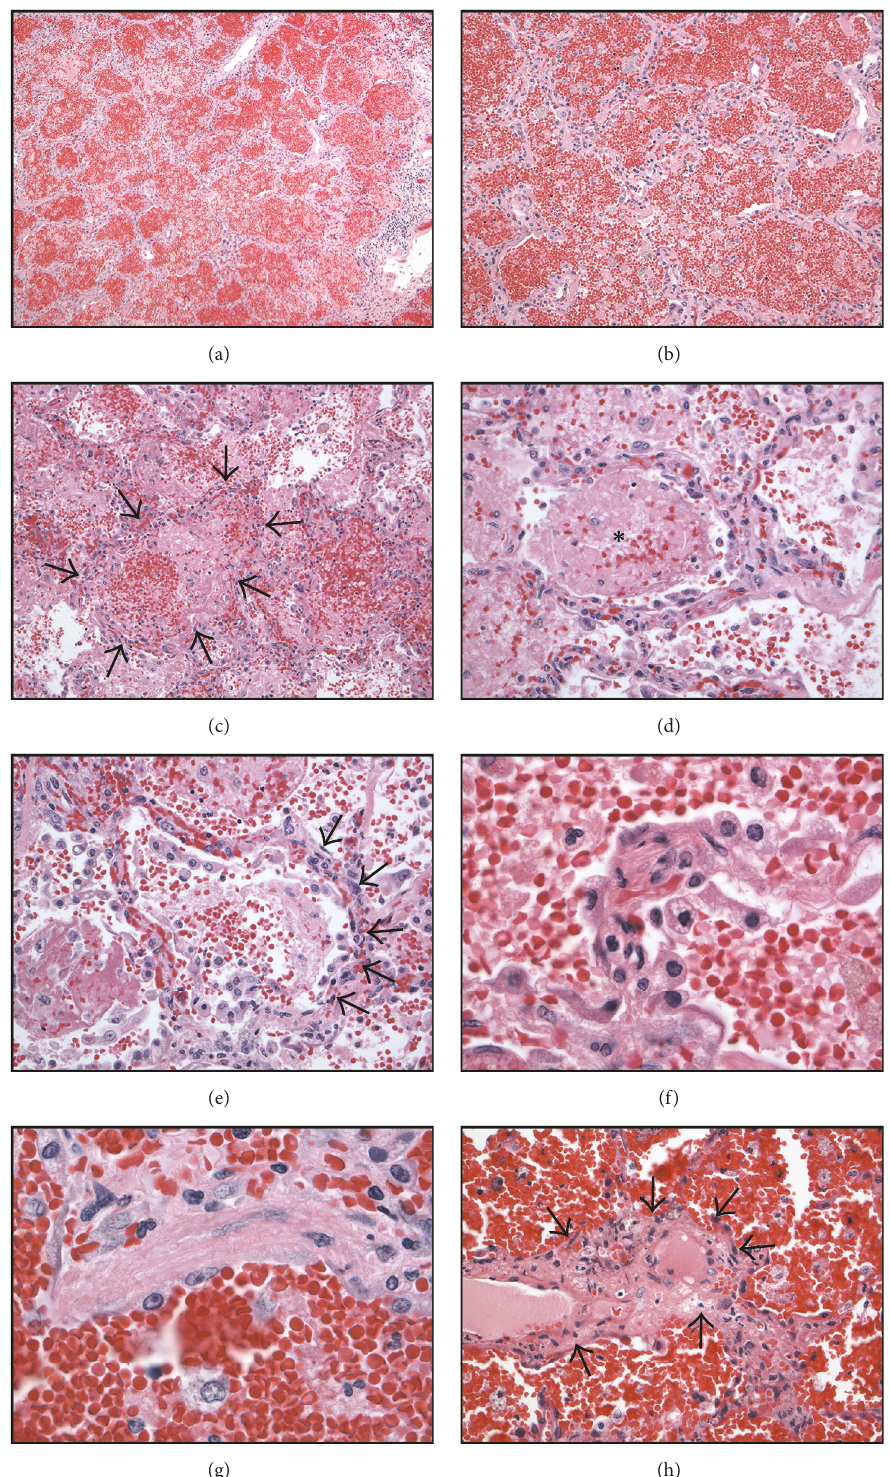
Figure 4: Lung with diffuse alveolar hemorrhage (H&E stain). (a) Area in which all alveoli are filled with extravasated erythrocytes. (b) Higher power view of same region. Note the hypercellularity of the alveolar septa. (c) A mixture of red cells and fibrin predominates in some alveoli (arrows). (d) The central alveolus contains a fibrin plug (asterisk). The alveolar septum is hypercellular. (e) The alveolar septum shows capillaritis (arrows), an inflammatory infiltrate containing neutrophils that degenerate releasing toxic compounds, causing capillary injury and leakage of erythrocytes. (f) High power view of septum with capillaritis. (g) A hyaline membrane abuts a damaged alveolar septum. (h) There were occasional foci of small vessel vasculitis